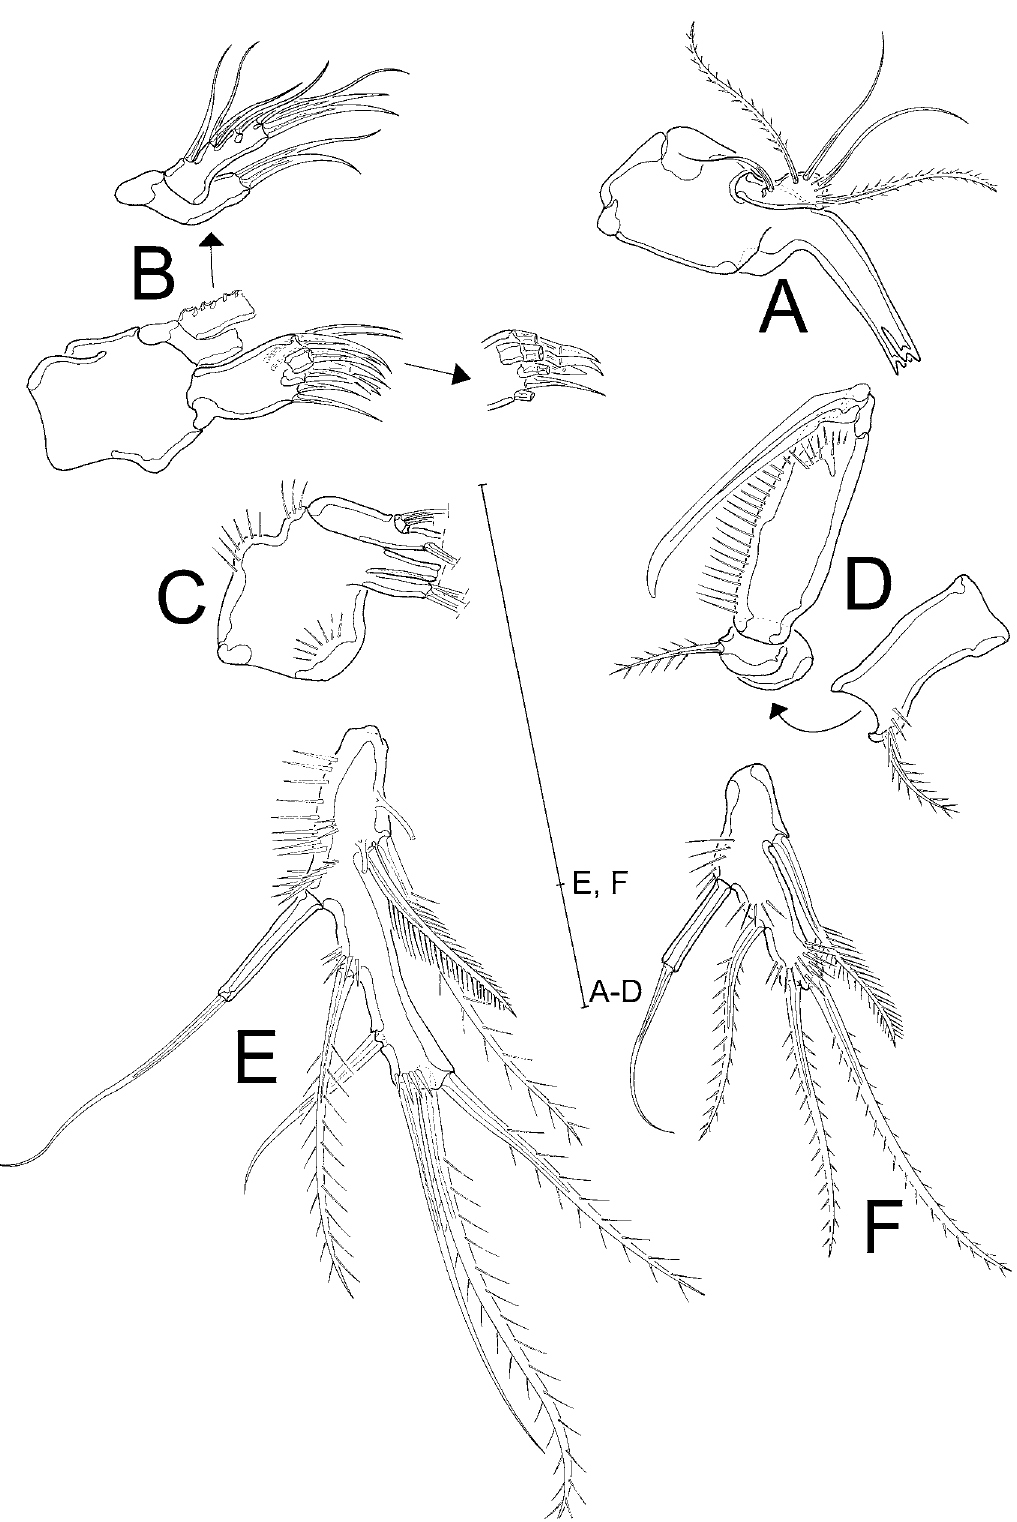
Fig. 4. Laophontodes typicus T. Scott, 1894, A–E . ♀ (A–D: BMNH 2015.1144–1153-1; E: BMNH 2015.1144–1153-3). A . Md B . Mxl. C . Mx. D . Mxp. E . P5. F . ♂ (BMNH 2015.1144–1153-2), P5. Scale bar = 50